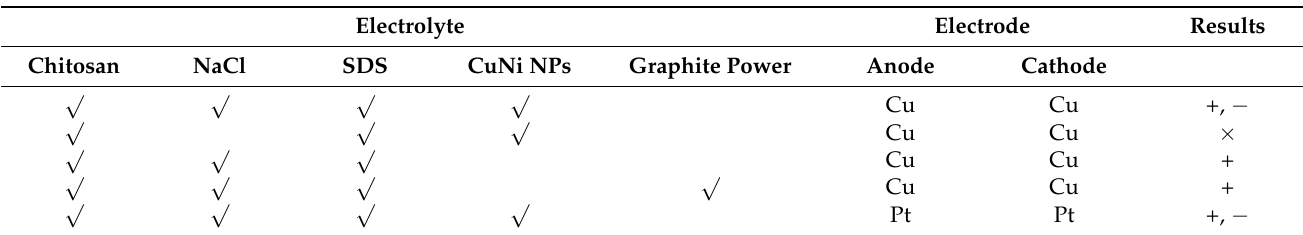
√ ) indicates the utilization of